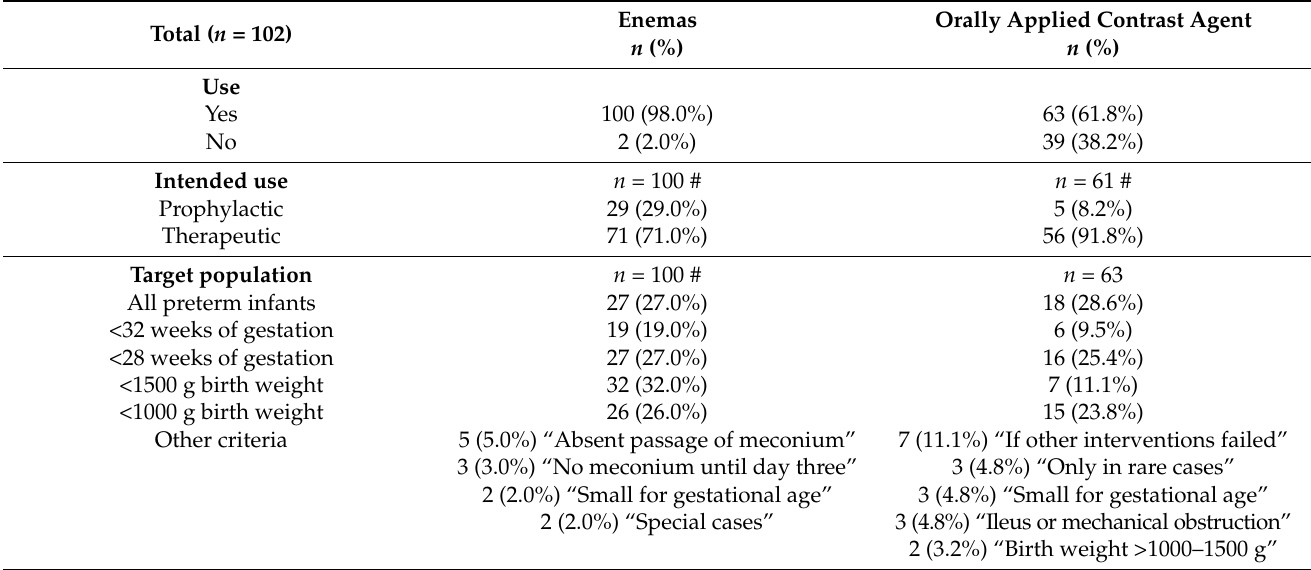
Table 1. Use of enemas and orally applied contrast agents to promote meconium